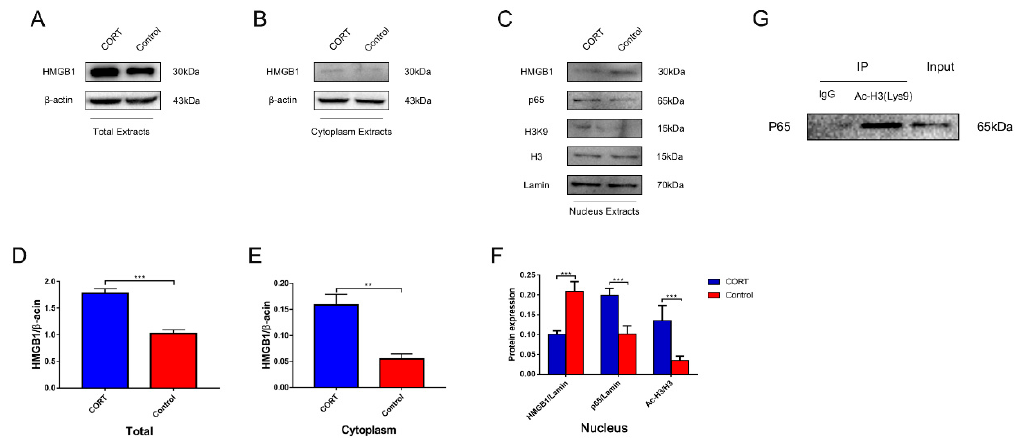
Figure 13. Expression of high-mobility group box (HMGB)1 in cortisol (CORT)-treated BV2 cells and interaction between H3K9 and p65. ( A – C ) Expression levels of HMGB1 in total cell ( A ) and cytoplasm ( B ) and HMGB1, p65, H3K9, histone H3, and lamin expression ( C ) in nuclear extracts after CORT (200 µ M) treatment for 3 h were evaluated by western blotting. Quantification of HMGB1, acetyl-p65, p65, H3K9, histone H3, and β -actin expression levels based on HMGB1 / β -actin ( D ), HMGB1 / β -actin ( E ), HMGB1 / β -actin, p65 / lamin, and H3K9 / histone H3 ( F ) ratios. Di ff erences between control and CORT groups were evaluated by one-way analysis of variance. Results are expressed as the mean ± SD ( n = 3) of three independent experiments. ** p < 0.01, *** p < 0.001. ( G ) Co-immunoprecipitation (Co-IP) of acetyl-histone H3 (Lys9) and p65 in BV2 cells with or without CORT treatment. Right to left, whole cell extracts (lane 1), immunoprecipitate obtained with anti-acetyl-histone H3 (Lys9) antibody (lane 2), and control IgG (lane 3) were probed with the anti-HMGB1 antibody.